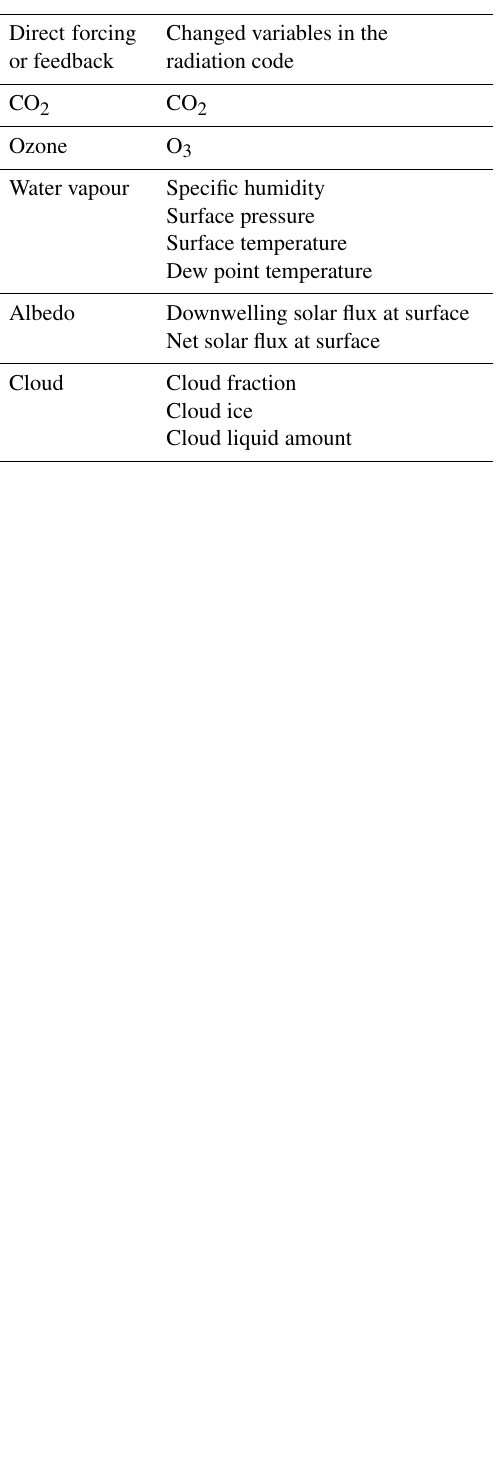
Table A1. The variables from the perturbation runs inserted in the radiation code of CFRAM to calculate the temperature change in re- sponse to the changes in CO 2 , O 3 , water vapour, cloud and